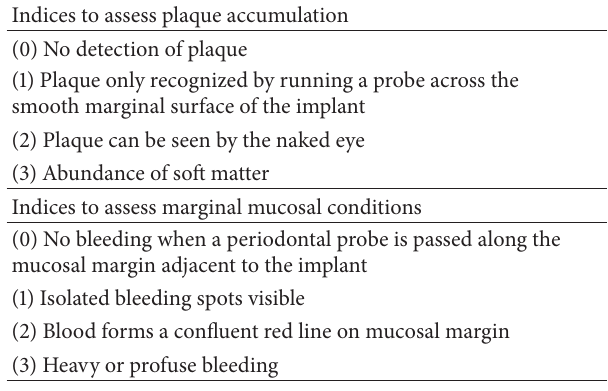
Figure 10: System protection with rubber dam to capture the titani- um cylinders and distal bar. Table 2: Indices used to assess plaque accumulation and marginal mucosal conditions around oral implants according to Mombelli et al.